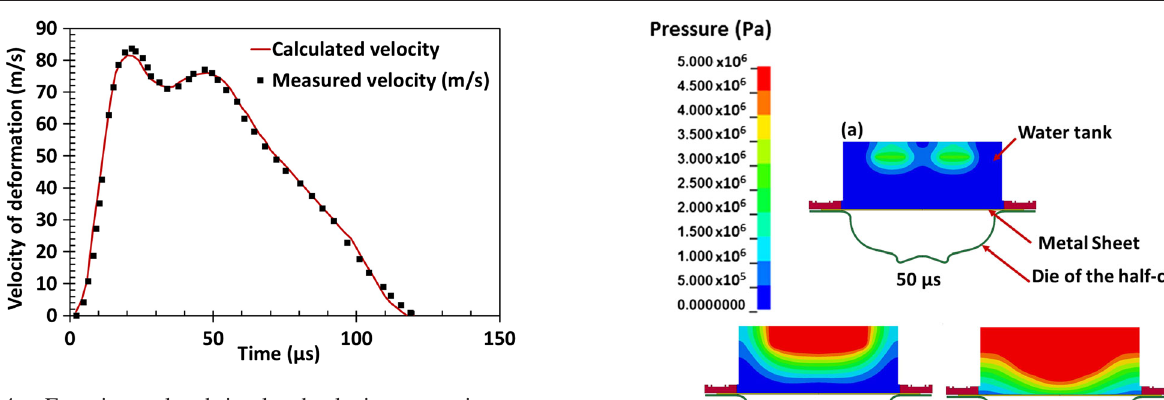
FIG. 4. Experimental and simulated velocity versus time curves for tube expansion test.